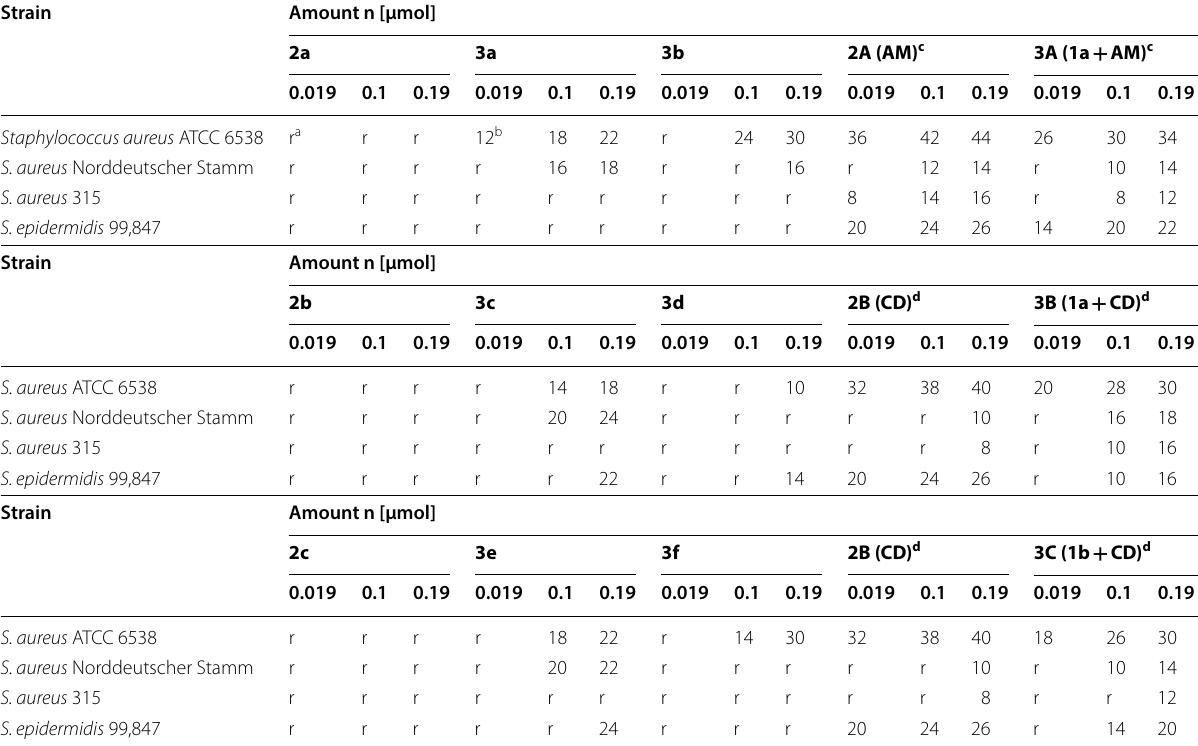
a Resistant (no zone of inhibition) b Zones of inhibition (mm) c Educt 2A and product 3A are described previously (Mikolasch et al. 2006); AM